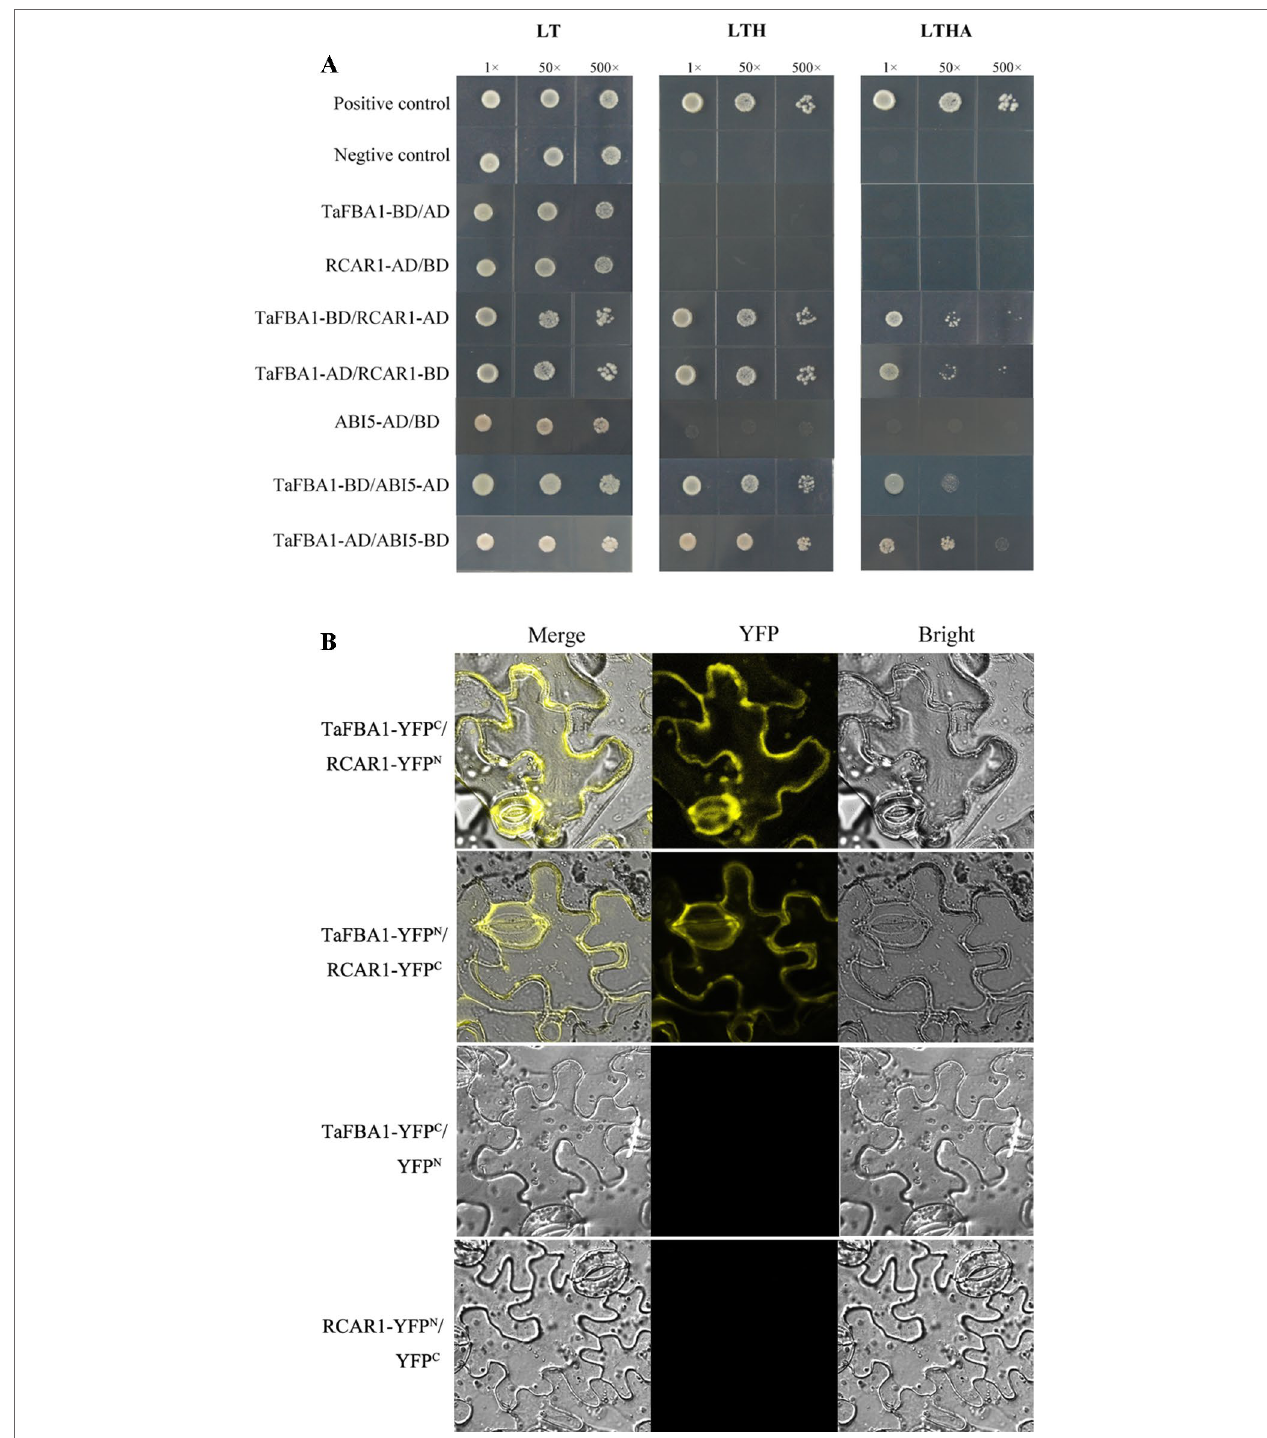
FIGURE 10 | The interactions of TaFBA1 with RCAR1 (an ABA receptor) and ABI5. (A) Interactions of TaFBA1 with RCAR1 and ABI5 were analyzed via the yeast two-hybrid assay. Interaction between pGADT7-324 and pGBKT7-332, pGADT7-322 and pGBKT7-332, were used as a positive and negative controls, respectively. LT, LYH, and LTHA represent the selective media SD-Leu-Trp, SD-Leu-Trp-His, and SD-Leu-Trp-His-Ade, respectively. (B) BiFC assays were used to determine the interaction between TaFBA1 and RCAR1 using yellow fluorescence signal. nYFP denotes expression of the YFP N-terminal fusion construct. cYFP denotes expression of the YFP C-terminal fusion